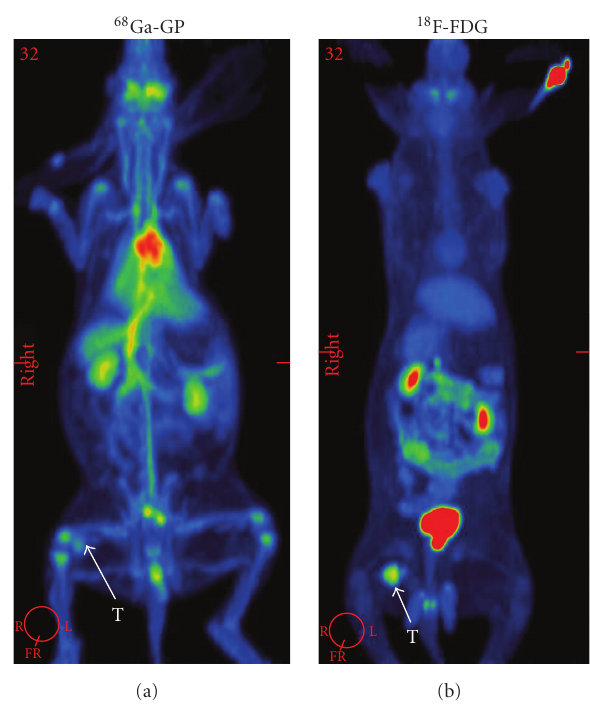
Figure 6: PET whole body at 45min in New Zealand white rabbits bearing VX2